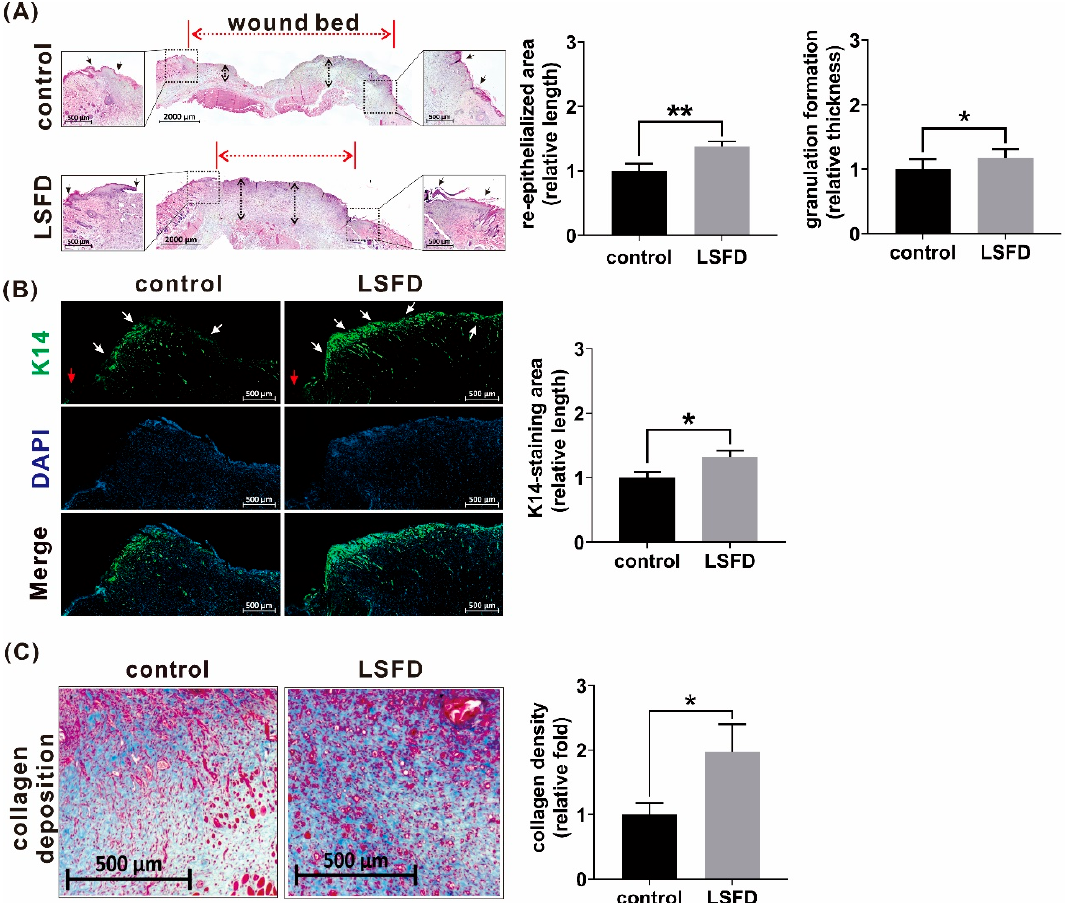
Figure 3. Histological characterization of rat burn wounds. ( A ) Hematoxylin and eosin staining of β -sheet LSFD-treated and control group tissue at day 10 post-wounding, showing the length of the re-epithelialized area and the thickness of the granulation tissue formation area. Black arrows: the distance from the original wound edges to re-epithelialized edges; black dashed arrows: granulation thickness; red dashed arrows: wound bed. ( B ) K14-immunofluorescence staining of epithelial tongues at day 10 post-wounding. White arrows: epithelial tongue area; red arrows: original wound edges; DAPI, 4 ′ ,6-diamidino-2-phenylindole ( C ) Masson’s Trichrome staining showing collagen deposition in rat skin at day 10 post-wounding. Quantitative data are presented as the mean ± standard error of the mean ( n = 6; * p < 0.05, ** p < 0.01).